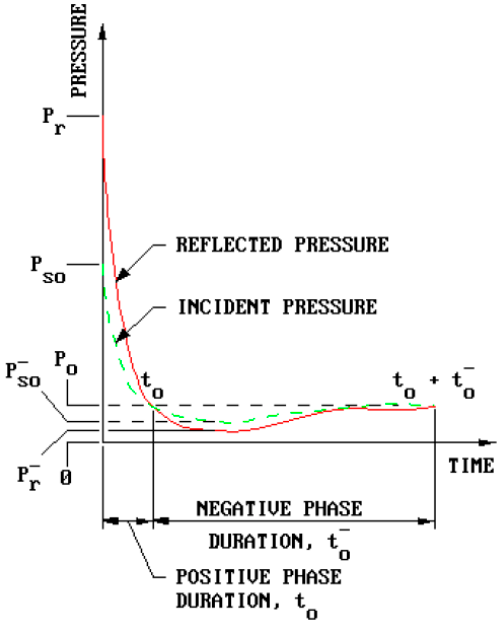
Figure 2. Pressure-time curve of a blast load [15].